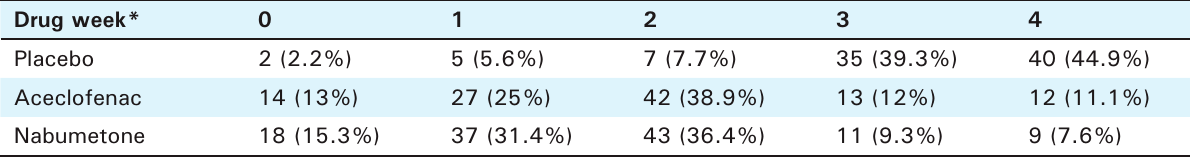
Table 4. Disease status of the study population (IGADS: 0-4 point scale) Drug week*